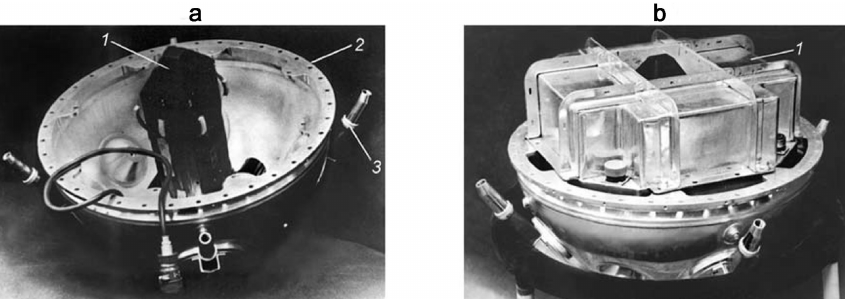
Figure 14. Internal layout of Sputnik 1: (a) with removed batteries (1 – radio transmitter, 2 – front half-shell, 3 – antenna flexible joint); (b) with installed batteries (Petrukovich et al., 2009).